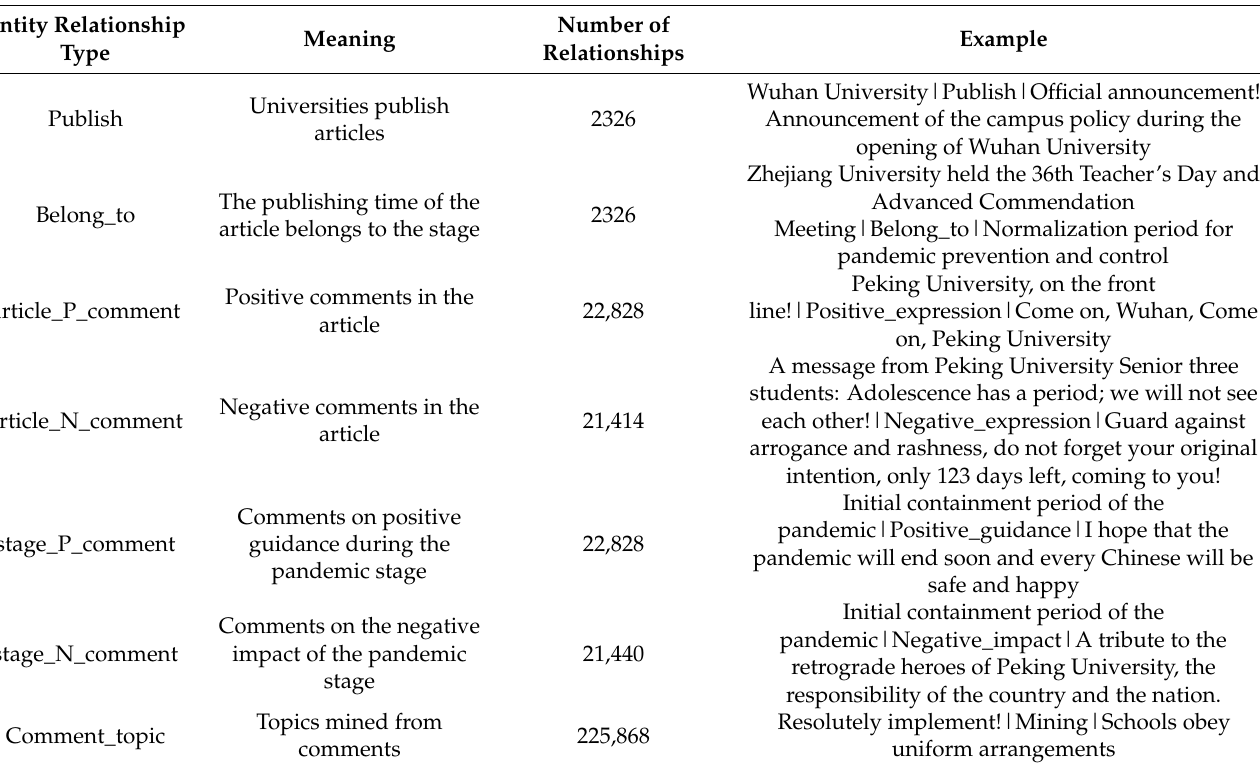
Table A3. Knowledge graph relationship